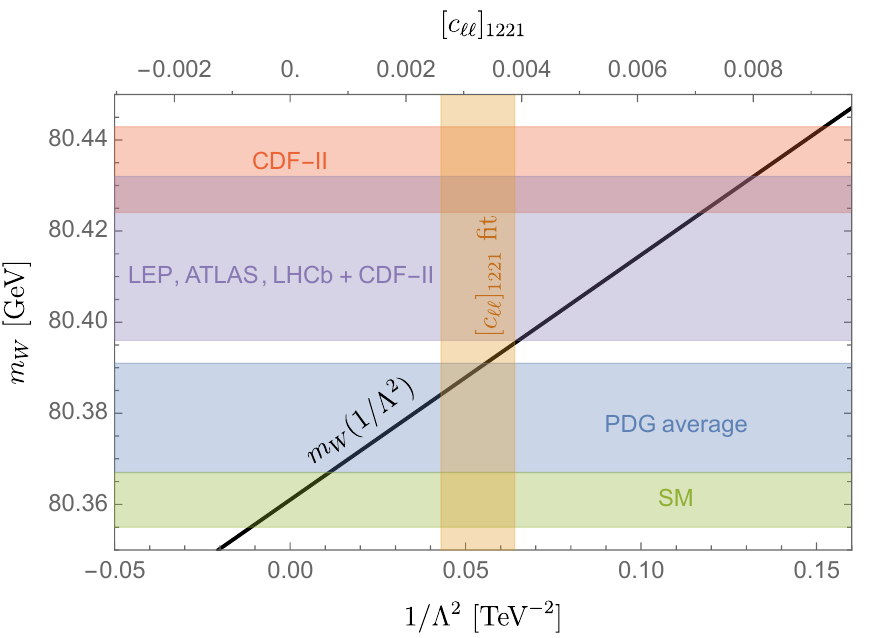
Figure 1 . The results of an electroweak fit, where only 1 / Λ 2 = [ c ‘‘ ] 1221 /v 2 is allowed to be nonzero (orange band). The horizontal bands show the 1 σ range of m W measurement: the PDG average (blue), the recent CDF measurement (red), and our naive average of the two (magenta), along with the prediction of the SM electroweak fit (green). The black line shows the dependence of m W on 1 / Λ 2